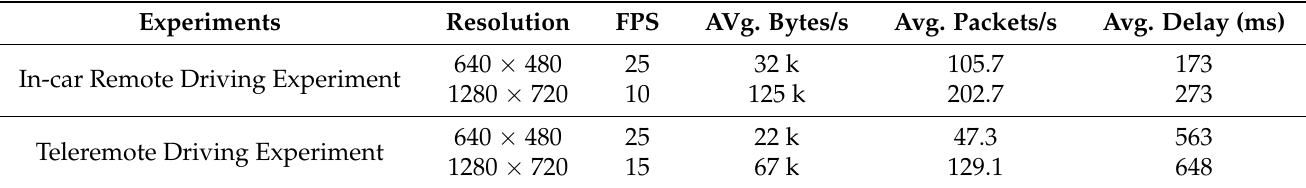
Table 3. Video streaming statistics results for both of the